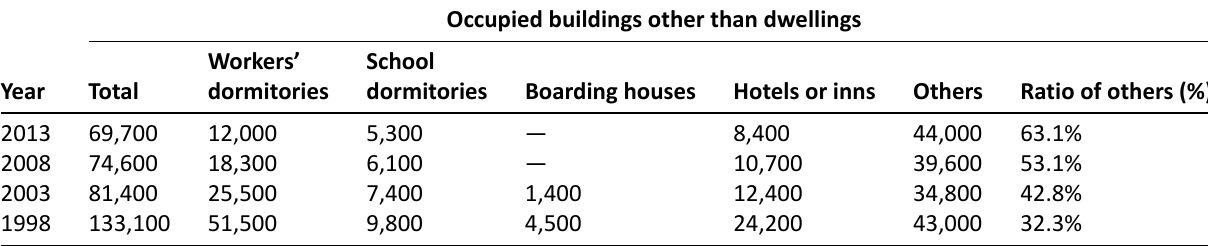
Table 2. Trends of number of occupied buildings other than